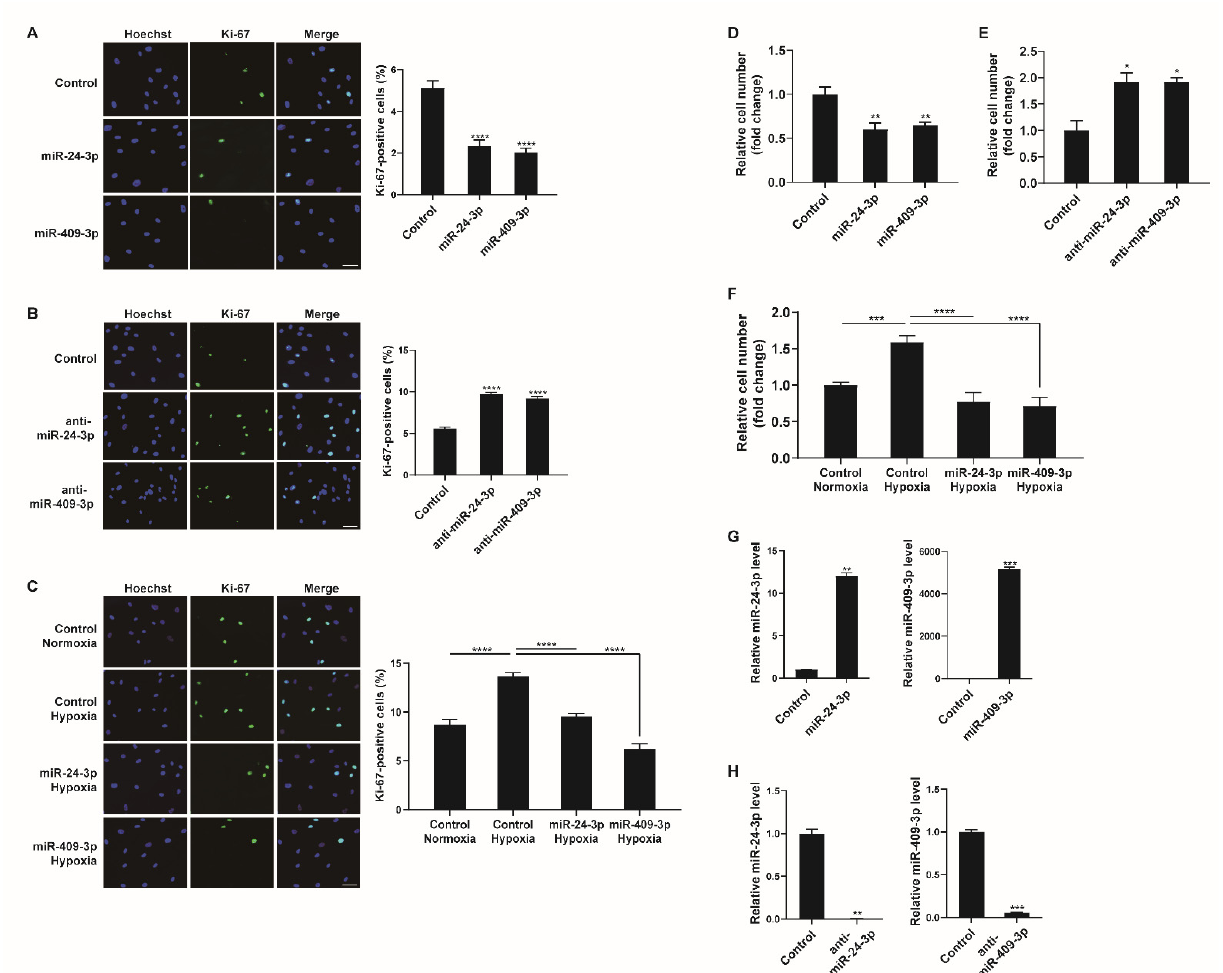
Figure 6. Hypoxia − mediated regulation of miR-24-3p and miR-409-3p affects PASMC proliferation. ( A , B ) Representative images of Ki-67 immunostaining of PASMCs transfected with control, miR-24-3p mimic, miR-409-3p mimic, anti-miR-24-3p, or anti-miR-409-3p for 24 h, and calculation of the Ki-67 index. The results are the mean ± S.E. for three independent assays. Scale bar represents 50 µ m. ( C ) Immunostaining analysis of PASMCs transfected with control, miR-24-3p mimic, or miR-409-3p mimic after exposure to hypoxia for 24 h. Approximately 200 cells from at least 10 independent fields were counted for each condition, and Ki − 67-positive cells are presented as a percentage of the total population. The results are the mean ± S.E. for three independent assays. Scale bar represents 50 µ m. ( D , E ) PASMCs were transfected with control, miR-24-3p mimic, miR-409-3p mimic, anti-miR-24-3p, or anti-miR-409-3p. Cells were trypsinized and counted using a hemacytometer. The relative number of cells was shown as a fold change. ( F ) PASMCs were transfected with miR-24-3p, or miR-409-3p mimics, followed by hypoxia exposure and the cell counting assay. ( G , H ) Levels of the miR-24-3p or miR-409-3p relative to U6 snRNA measured by qRT − PCR in PASMCs transfected with the